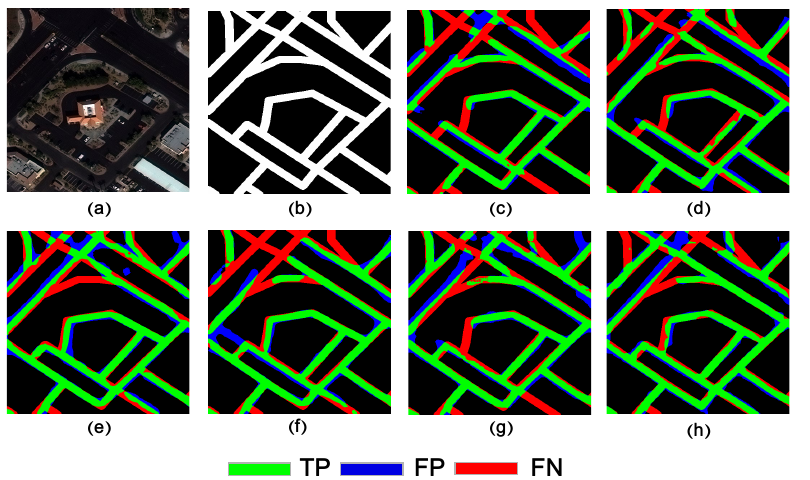
Figure 13. Results of ablation experiments on the SpaceNet dataset. ( a ) RGB satellite imagery. ( b ) Ground truth. ( c ) HRNet. ( d ) HRNet with multispectral input. ( e ) MSFANet without multispectral input and CFFM. ( f ) MSFANet without multispectral input. ( g ) MSFANet without MFAD module. ( h )